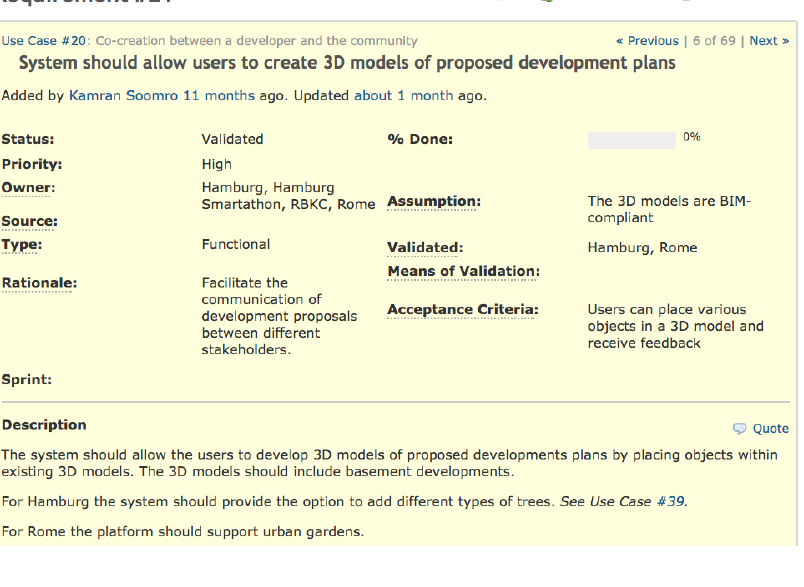
Figure 2. Smarticipate requirements management.